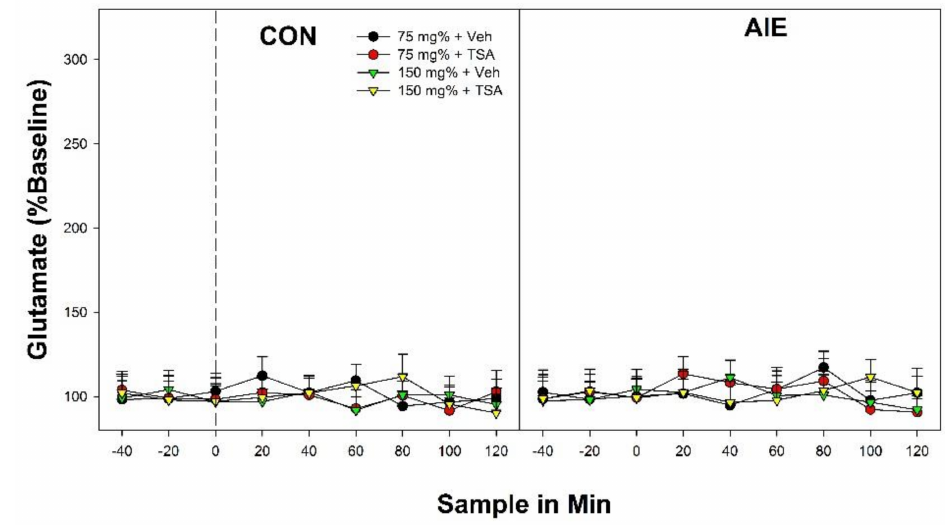
Figure 6. Glutamate levels (%Baseline) in the AcbSh following microinjections of EtOH into the posterior VTA in male Wistar rats that received water treatment (CON; left panel) or binge-EtOH exposure during adolescence (AIE; right panel) following pretreatment/treatment with the HDAC inhibitor Trichostatin A (TSA). There were no observed alterations in glutamate levels in any group. Data are mean ±